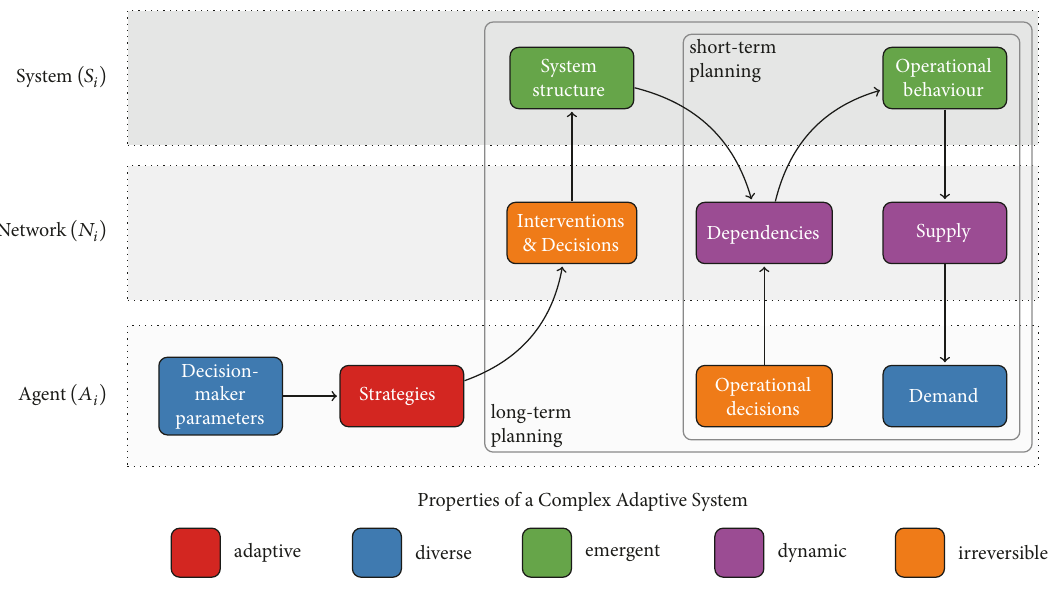
Figure 2: Mapping the properties of a complex adaptive system to a system-of-systems